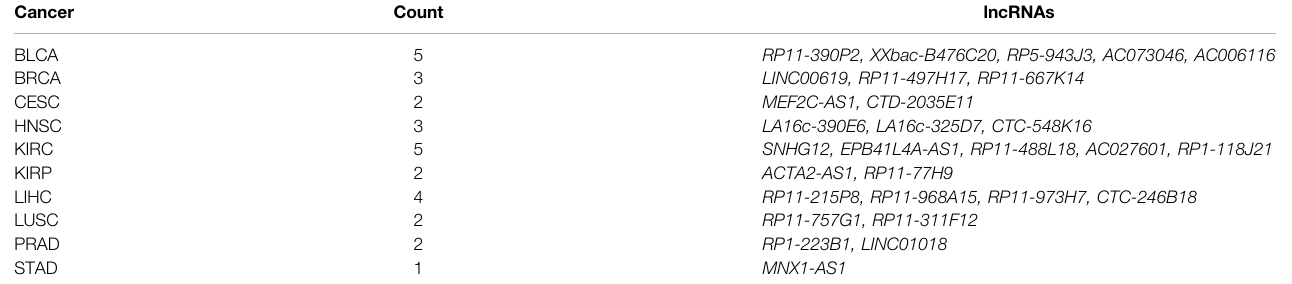
TABLE 5 | Signi fi cantly survival associated lncRNAs in negatively correlated lncRNAs for each cancer. Cancer